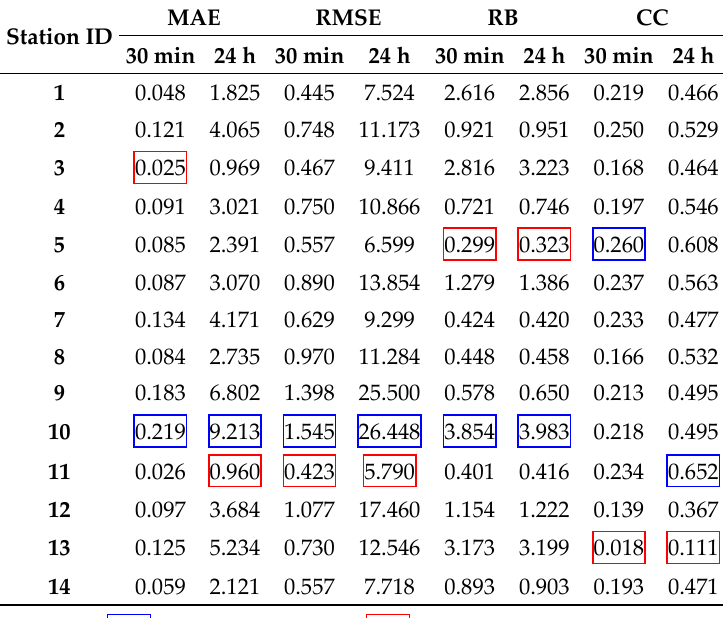
Table 7. Overall results of the precision quantification or discrepancy between the CMORPH estimates and the precipitation data of the rain gauges.